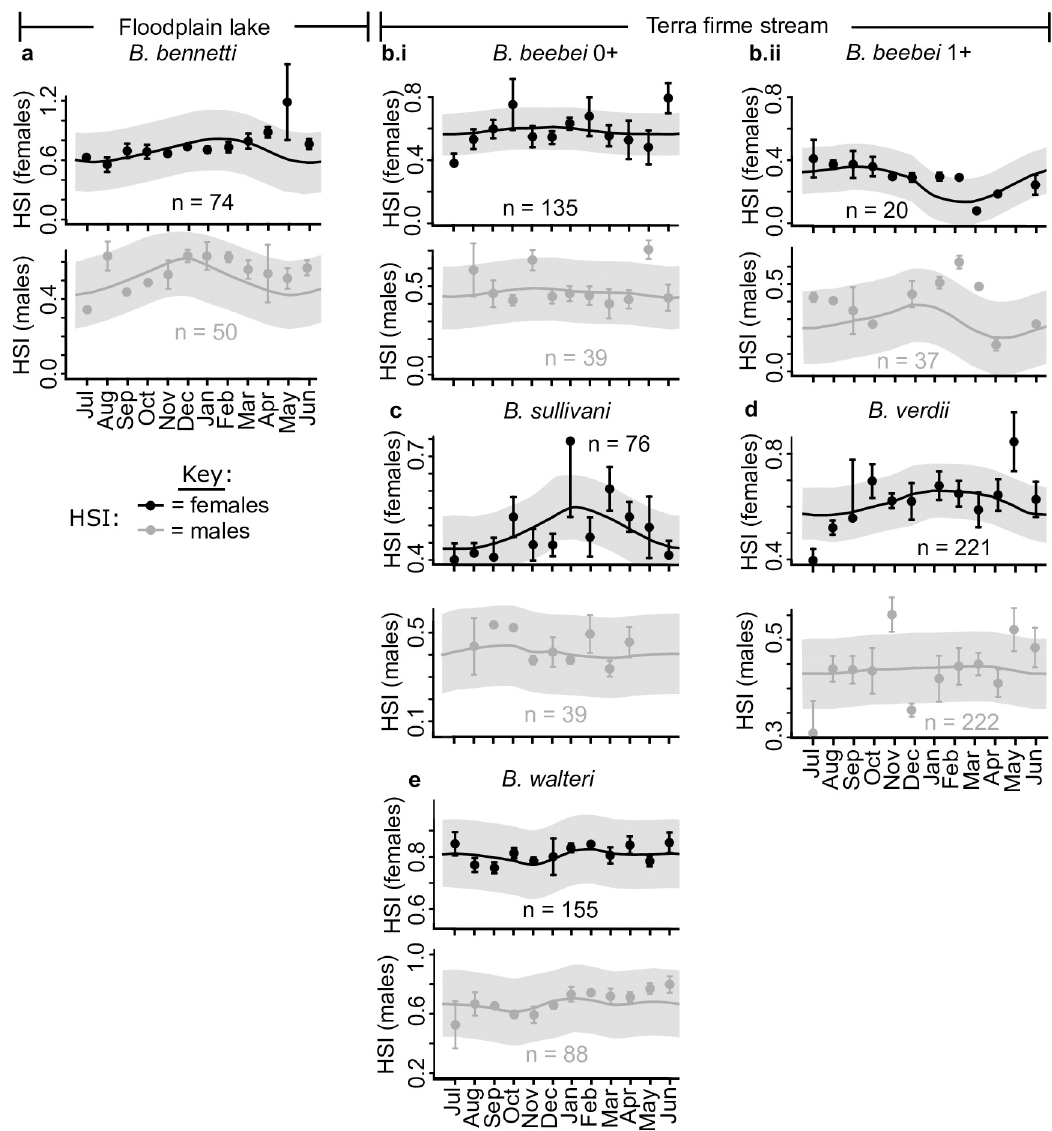
Fig 9. Circannual variation in hepatosomatic index for all sexed individuals (gonad Stages 2–5) of five species of Brachyhypopomus . See Fig 8 caption for further